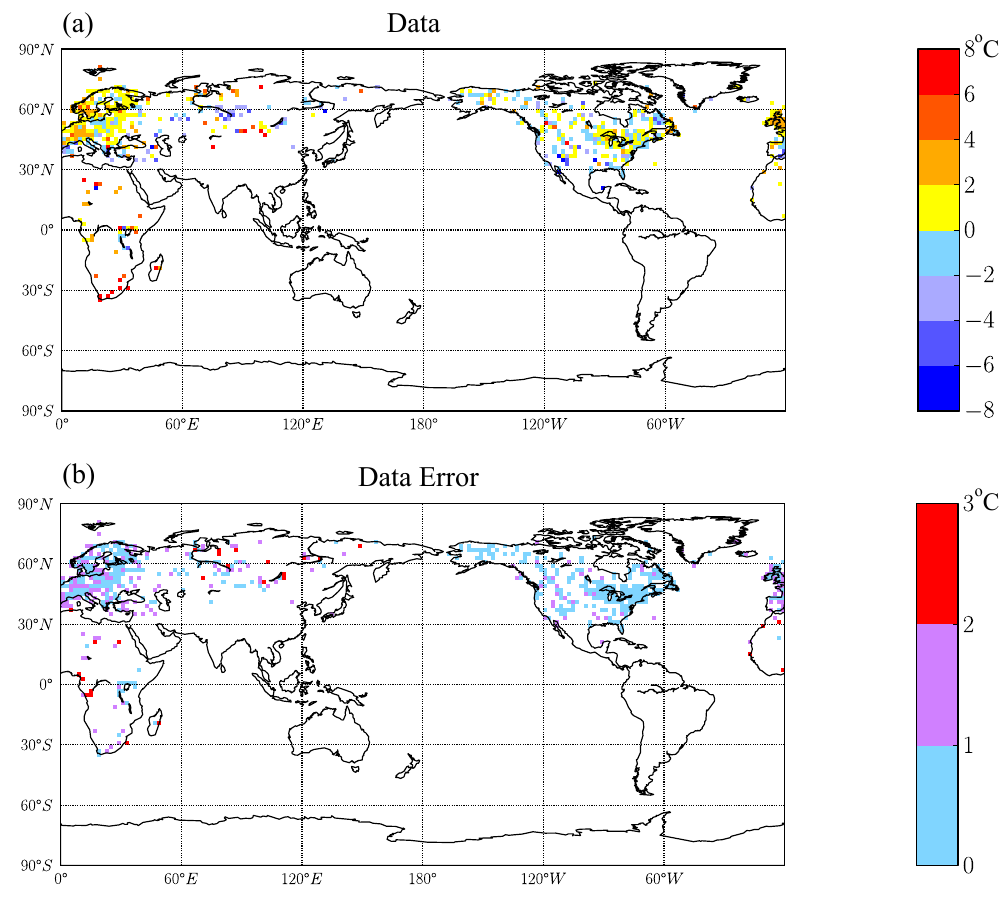
Fig. 2. Mid-Holocene temperature anomaly for the hottest month from the proxy reconstructions described in Sect. 2.2: (a) data, Max=10.0 ◦ C, Min= − 20.1 ◦ C, (b) data error, Max=3.3, Min=0.05,